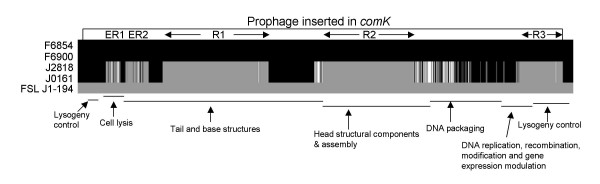
Schematic of recombination events in comK prophage. The figure represents an alignment of the 1892 polymorphic sites in the comK prophage (including coding and non-coding regions) as well as 13 polymorphic sites immediately upstream the prophage and 41 polymorphic sites immediately downstream of the prophage. Sites representing nt residues found in F6854 and F6900 (1988 isolates) are shown in black and sites representing nt residues found in FSL J1-194 (a L. monocytogenes serotype 1/2b isolate with the comK prophage most closely related to the prophage found in the 2000 isolates) are shown in gray. The nt sites in J0161 and J2818 (2000 isolates) are shaded so that nt identical to the 1988 isolates are in black, nt identical to FSL J1-194 are in gray, and nt that match neither the 1988 isolates nor FSL J1-194 are in white. Apparent darker shades of gray in this figure represent adjacent sites with black and gray or white. R1, R2, and R3 (recombination 1 to 3) represent three main recombinant blocks that were likely introduced from a lineage I strain similar to FSL J1-194 into a descended of the 1988 isolates, yielding the 2000 isolate genotype. The two shorter mixed gray and white blocks at the 5' end, marked as ER1 and ER 2 (ER = external recombination) are likely to have been introduced from a L. monocytogenes genotype not included in this alignment ("external") into a descendent of the 1988 isolates.